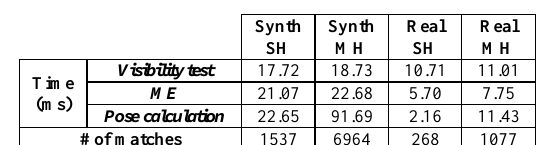
C OMPARISON TABLE OF TIMES AND # OF MATCHES FOR THE PS TRACKING ALGORITHM